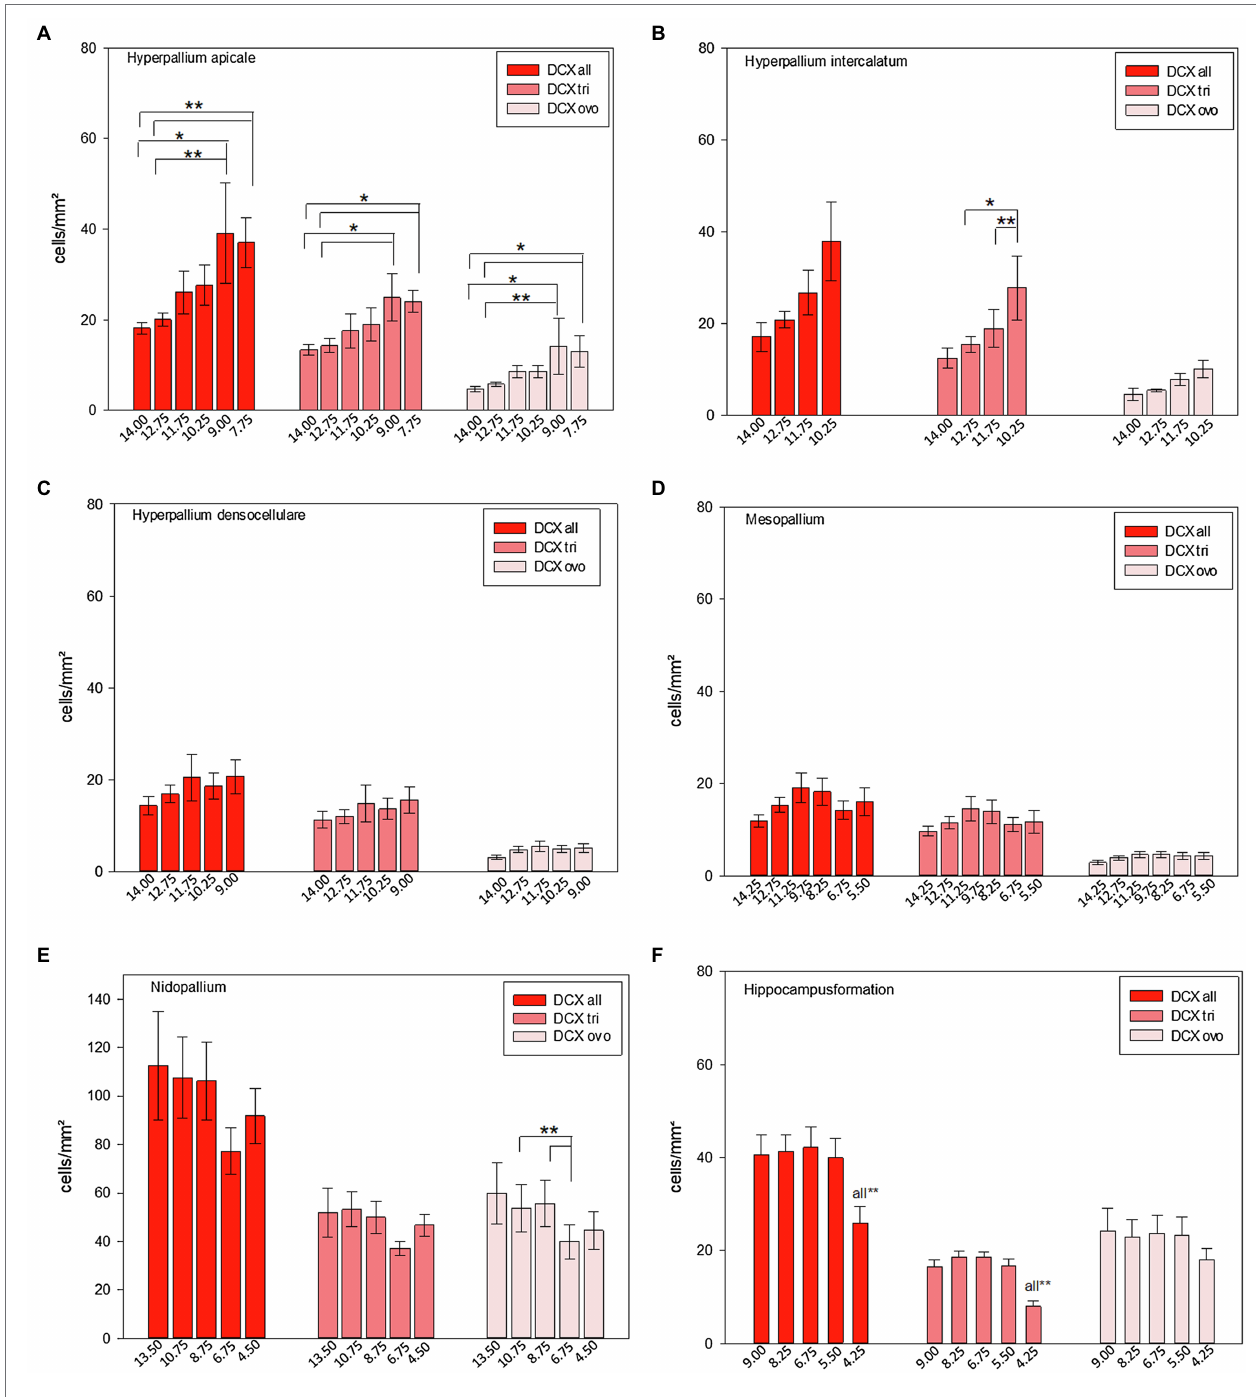
FIGURE 12 | Distribution of DCX+ cells/mm 2 of different atlas levels along the anterior–posterior axis in different regions of the pigeon ( n = 9). (A) Hyperpallium apicale, (B) Hyperpallium intercalatum, (C) Hyperpallium densocellulare, (D) Mesopallium, (E) Nidopallium, (F) Hippocampal formation. Two different types of DCX+ cells were recognized, triangular ( − tri) and ovoid ( − ovo) cells. Atlas level A13.50 in nidopallium represents NF, A10.75 and A8.75 NI and A6.75 and A4.50 NC. Bars represent mean ± SE. Asterisks indicate significant differences (Wilcoxon Signed Rank Test, * p < 0.05, ** p <